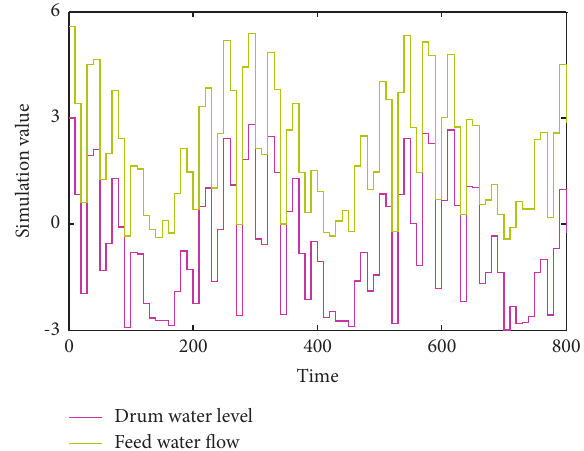
Figure 8: Simulation results of the main controller of the water supply control